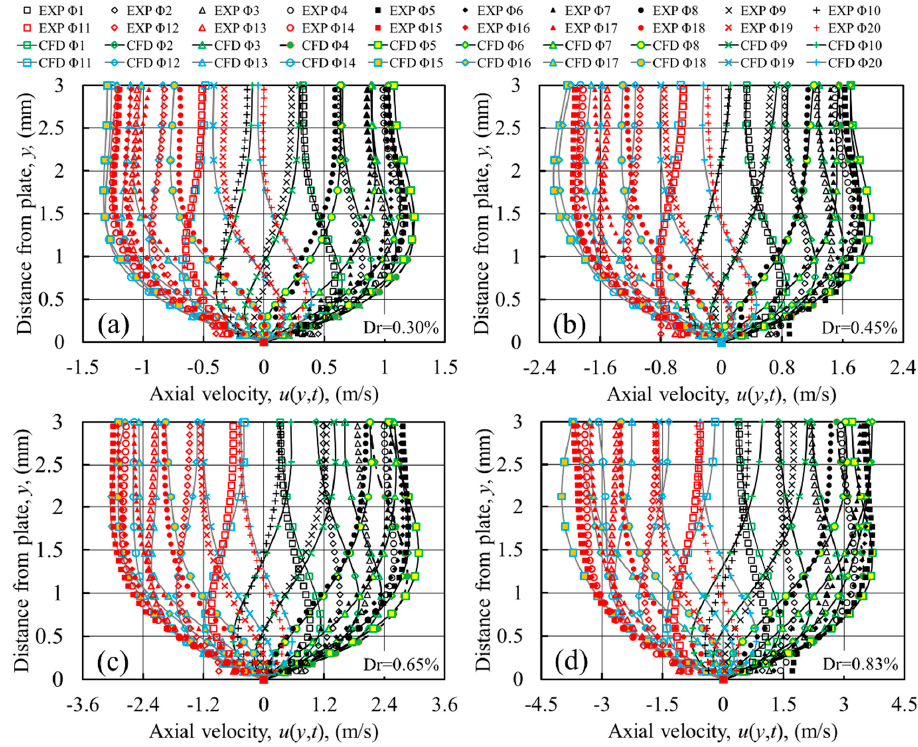
Figure 4. Velocity profiles at location 10 mm away from the joint, within the cold channel, for drive ratio (Dr): ( a ) 0.30%, ( b ) 0.45%, ( c ) 0.65% and ( d ) 0.83%. Numerical results based on laminar model. EXP refers to experimental results.